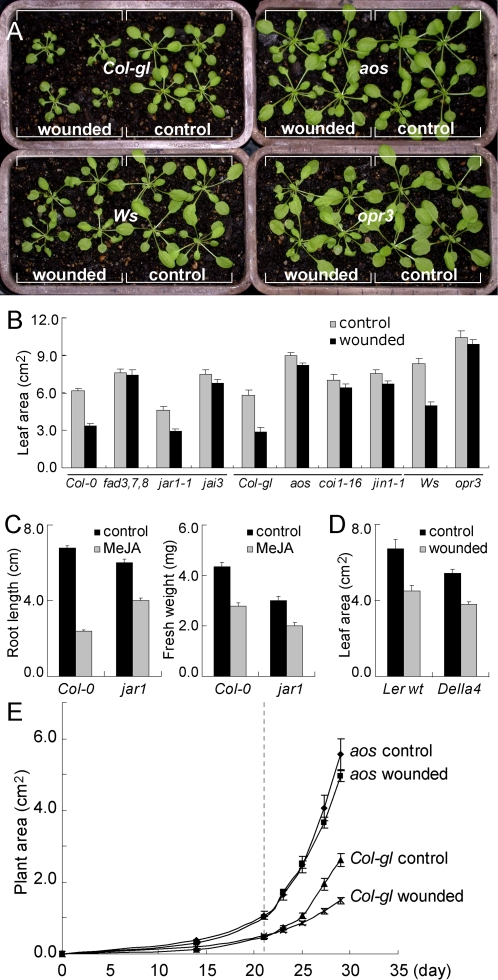
Effect of wounding on growth of wild type plants and JA mutants.(A) Thirty-one-day old wild type, aos (in Col-gl background), and opr3 (in Ws background) plants after wounding. Controls are unwounded. (B) Leaf area of unwounded and wounded 31-day-old wild type plants and JA mutants (n≥10). Lines underneath the histogram indicate the same genetic background, Col-0, Col-gl, or Ws. (C) Effect of MeJA on root length and fresh weight of wild type Col-0 and jar1 plants (n≥25). (D) Leaf area of unwounded and wounded 31-day-old wild type Ler and quadruple-DELLA mutant plants (n≥10). (E) Growth rates of control and wounded Col-gl and aos plants. Wounding of plants started on day 21, indicated by the dotted line (n = 12).